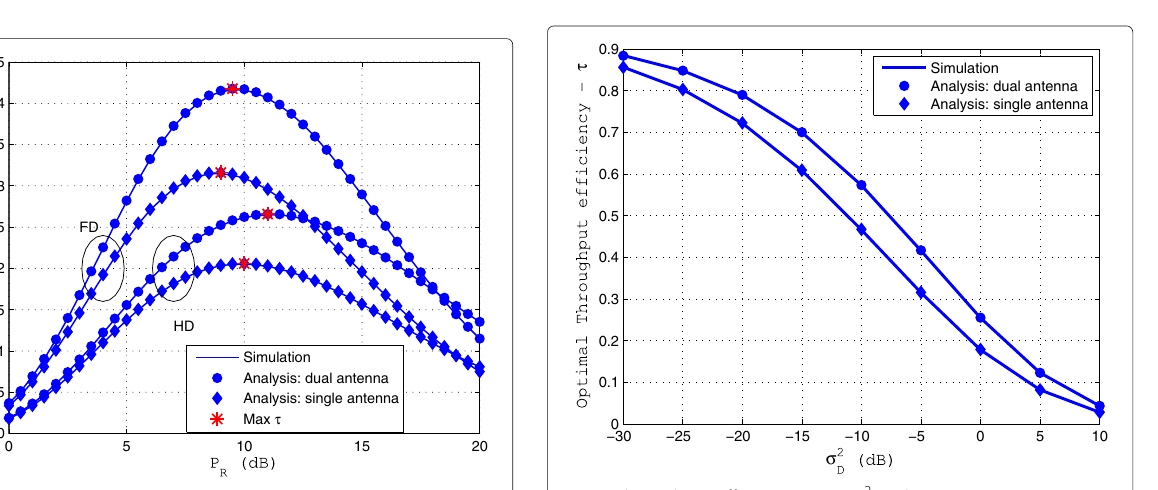
Fig. 4 Throughput efficiency versus P R in FD relay with m f = 1